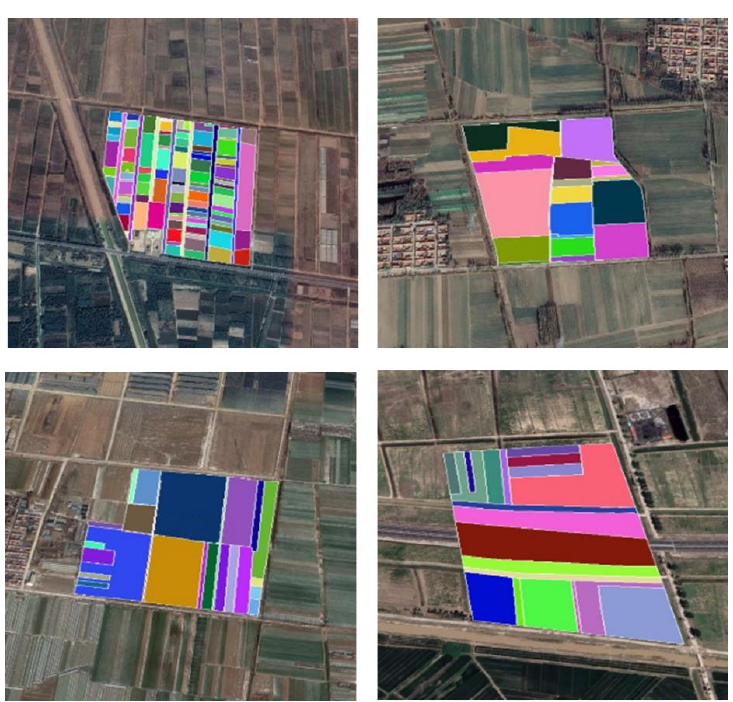
Figure 2. Scope of study area.